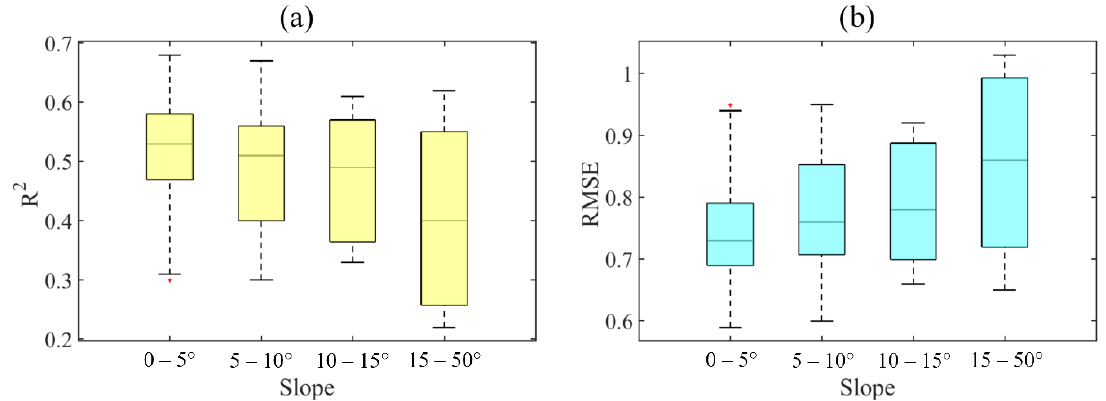
Figure 7. Boxplot summarizing the sensitivity of predicted SPEI to slope: ( a ) R 2 and ( b ) RMSE.